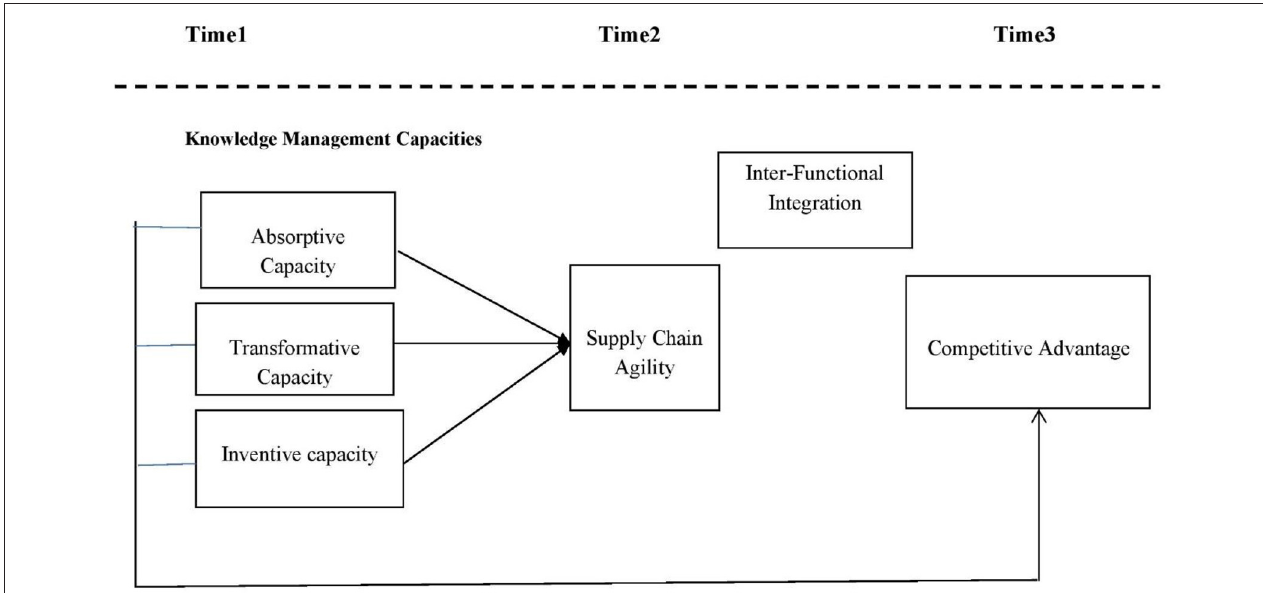
FIGURE 1 | Conceptual framework.